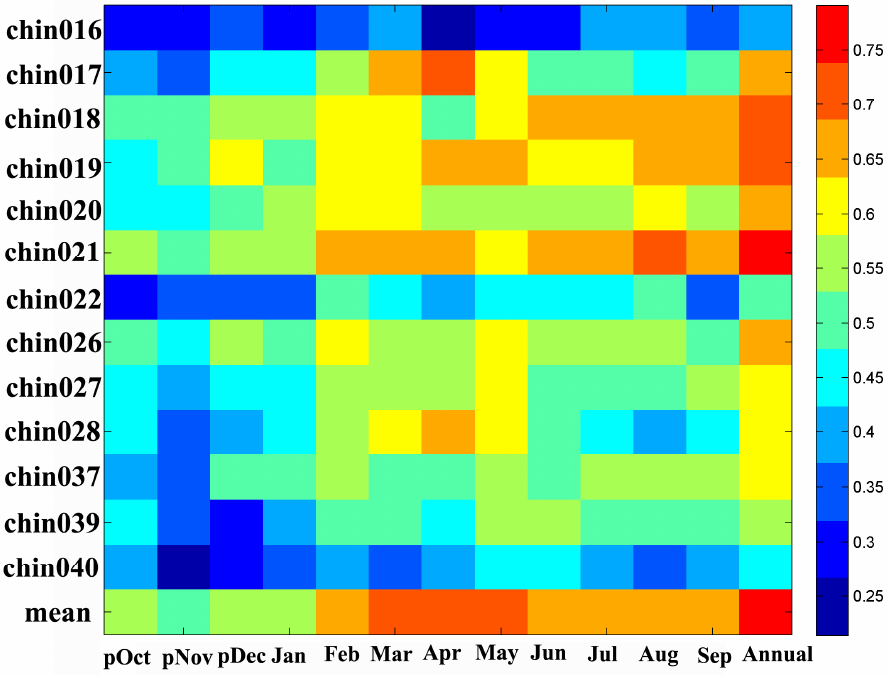
Figure 6. Correlation coefficients between regional mean signal-free chronology and simulated regional mean temperature (GCMs) at each month for the common period 1911–2005.